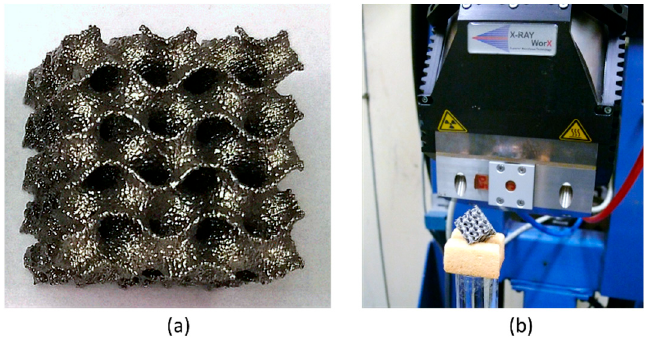
Figure 2. Photographs of ( a ) specimen with nominal WT of 0.4 mm; ( b ) the XCT experimental setup. Cubic specimens with constant porosity were designed with two different WT of 0.4 mm and 0.6 mm resulting in the specimens (15 mm × 15 mm × 15 mm) with